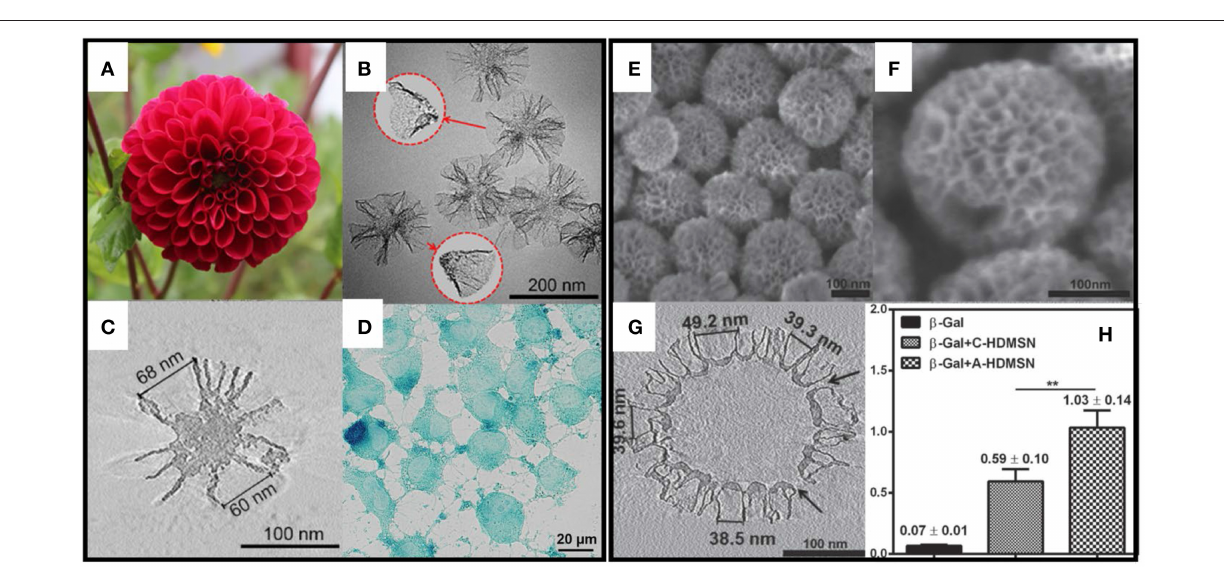
FIGURE 2 | MSNs with radial pore structure and their application for large protein ( β -Gal) delivery. (A–C) showed the structure of MSN-CC and (D) shows the intracellular delivery of β -Gal. (E–G) showed the structure of amino group modified hollow MSNs with radial pores. (H) showed the highest β -Gal delivery efficacy ** p < 0.01. Reproduced with permission from Xu et al. (2015), The Wiley-VCH and Meka et al. (2016), The